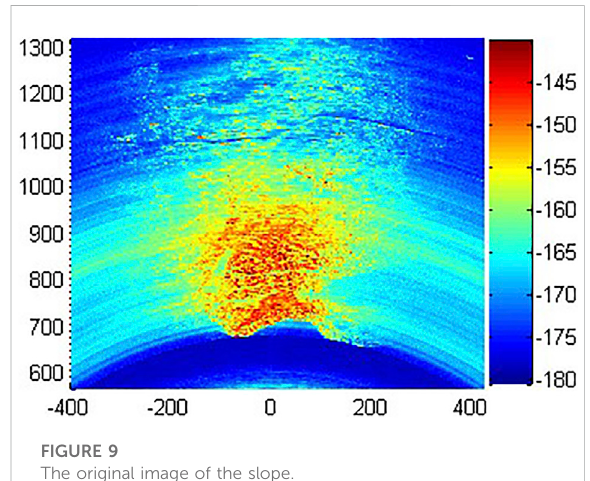
FIGURE 9 The original image of the